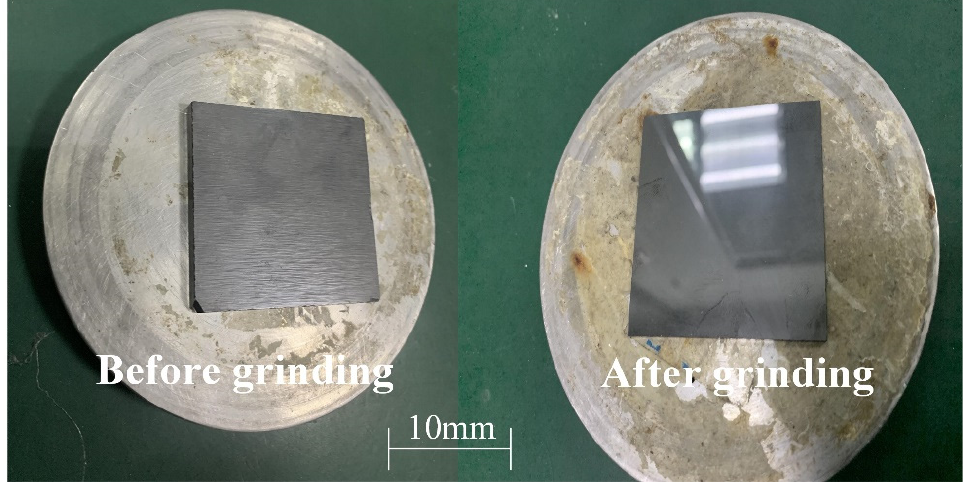
Figure 3. Silicon carbide substrate before and after